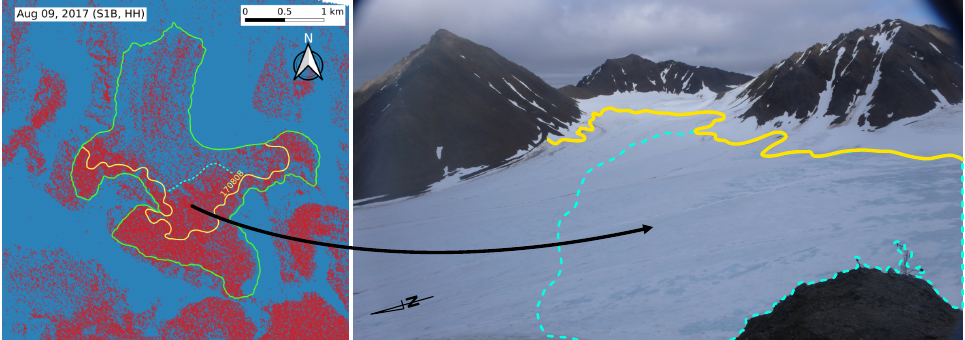
Figure 10. Comparison of the FSC limit deduced from ground-based oblique-view picture analysis (yellow line) and the reflectivity map of the Sentinel-1 data collected the same date ( left ). The discrepancy between the optical analysis and microwave reflectivity is highlighted on the original picture ( right ), emphasizing the complementarity of the two measurement techniques because some dark areas associated with bare ice during the ground-based picture analysis are still covered with snow patches detected as strongly absorbing (wet) regions by the spaceborne RADAR (blue dashed